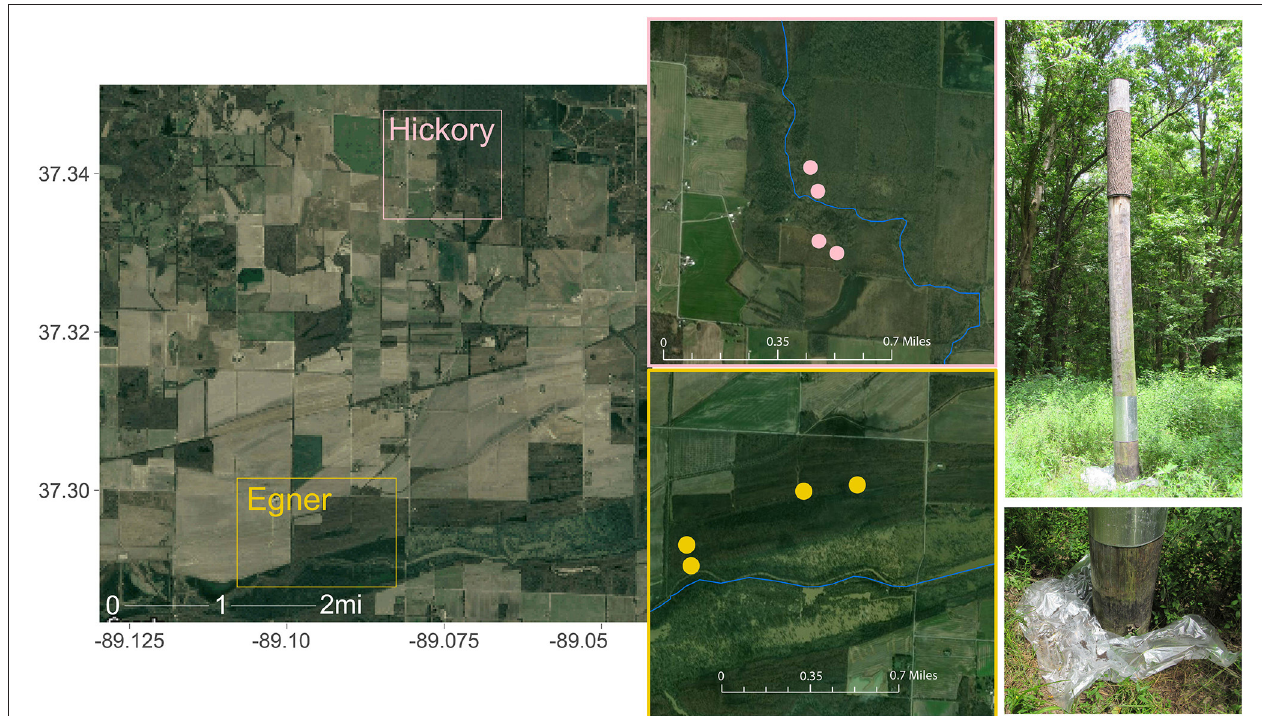
FIGURE 1 | Collection sites within Cypress Creek National Wildlife Refuge (CCNWR), which is situated in southern Illinois and consists of ∼ 17,000 acres of wetland, forested, and grassland habitats. The Cache River Unit comprises just 1,136 acres of riparian wetland forests essential to Indiana Bat foraging and roosting. Guano was collected from two locations ∼ 3 miles apart: Hickory Bottoms (Hickory) and Egner. Each collection area contained 4 artificial roosting habitats, depicted as points on each inset map. Sources: Google, ESRI, DigitalGlobe, GeoEye, Earthstar Geographics, CNES/Airbus DS, USDA, USGS, AeroGRID, IGN, and the GIS User